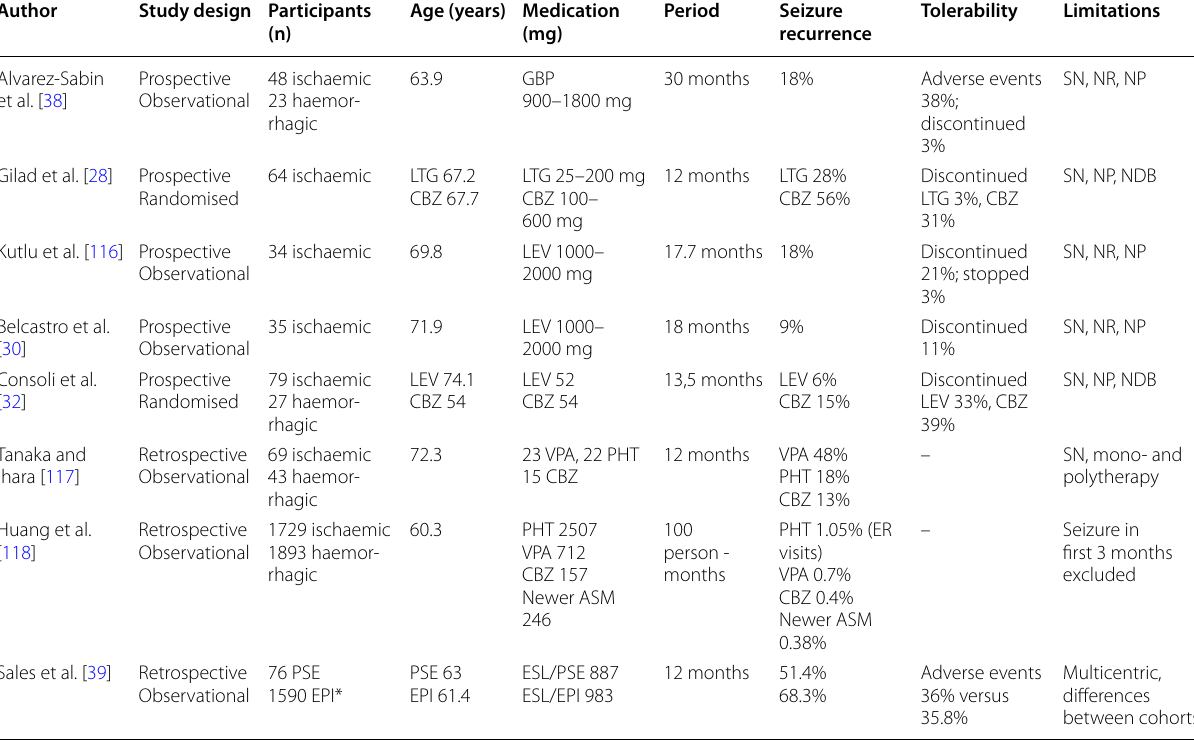
Publications reporting the clinical effectiveness and tolerance for anticonvulsants used for the treatment of PSE, modified after Tanaka and Ihara [117]. Abbreviations: ASM: anti-seizure medication, CBZ: carbamazepine, EPI: epilepsy not associated with stroke (* with differences in age, length of preceding epilepsy treatment), ER: emergency room, ESL: eslicarbazepine, GBP: gabapentin, LEV: levetiracetam, LTG: lamotrigine, NDB: not double-blind, NP: no placebo, NR: non-randomised, PHT: phenytoin, PSE: post-stroke epilepsy, SN: small number of patients; VPA: